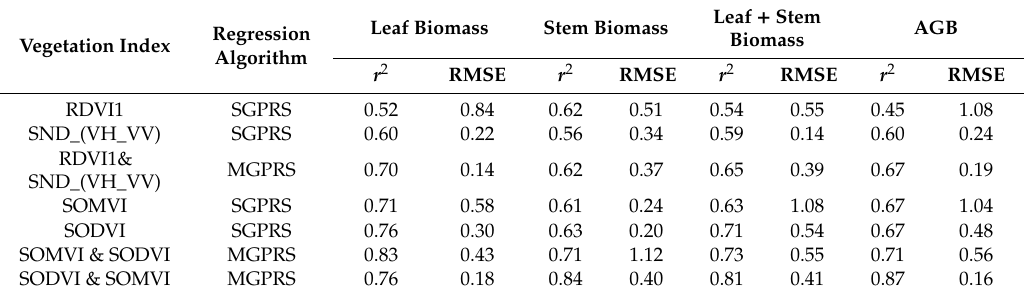
Table 4. Summary of correlation coe ffi cient estimation of rice biomass components with vegetation indices.